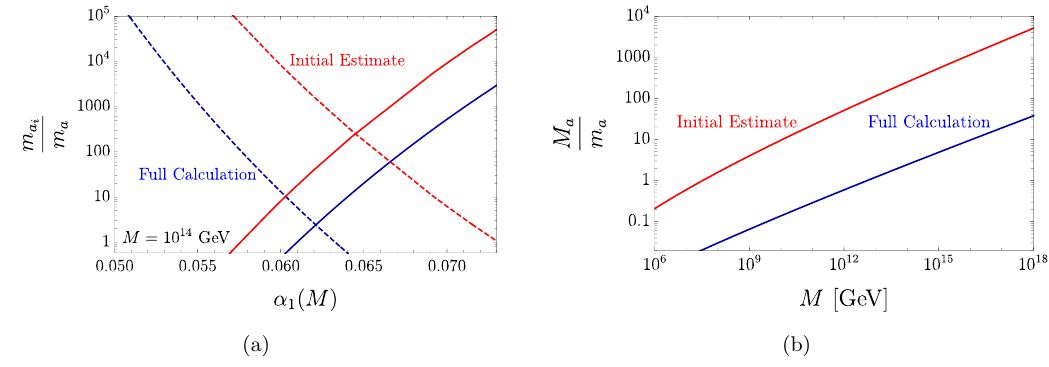
Figure 3 . Small instanton contribution to the axion mass relative to the IR QCD contributions in the model based on the symmetry breaking structure SU(3) (cid:2) SU(3) ! SU(3) QCD . On the left we show our results for the full calculation in blue compared to the initial estimates in previous work [12] in red at a breaking scale of M = 10 14 GeV as a function of (cid:11) 1 = g (dashed) curves show m a =m a ( m a =m a ), which intersect at M a =m a = 2 : 4 in the full calculation 1 2 and at M a =m a = 251 in previous estimates. On the right we show the values for M a =m a at the intersection point of m a =m a and m a =m a for a wide range of breaking scales M . In both plots we 1 2 took f a = f a = f a 1 2